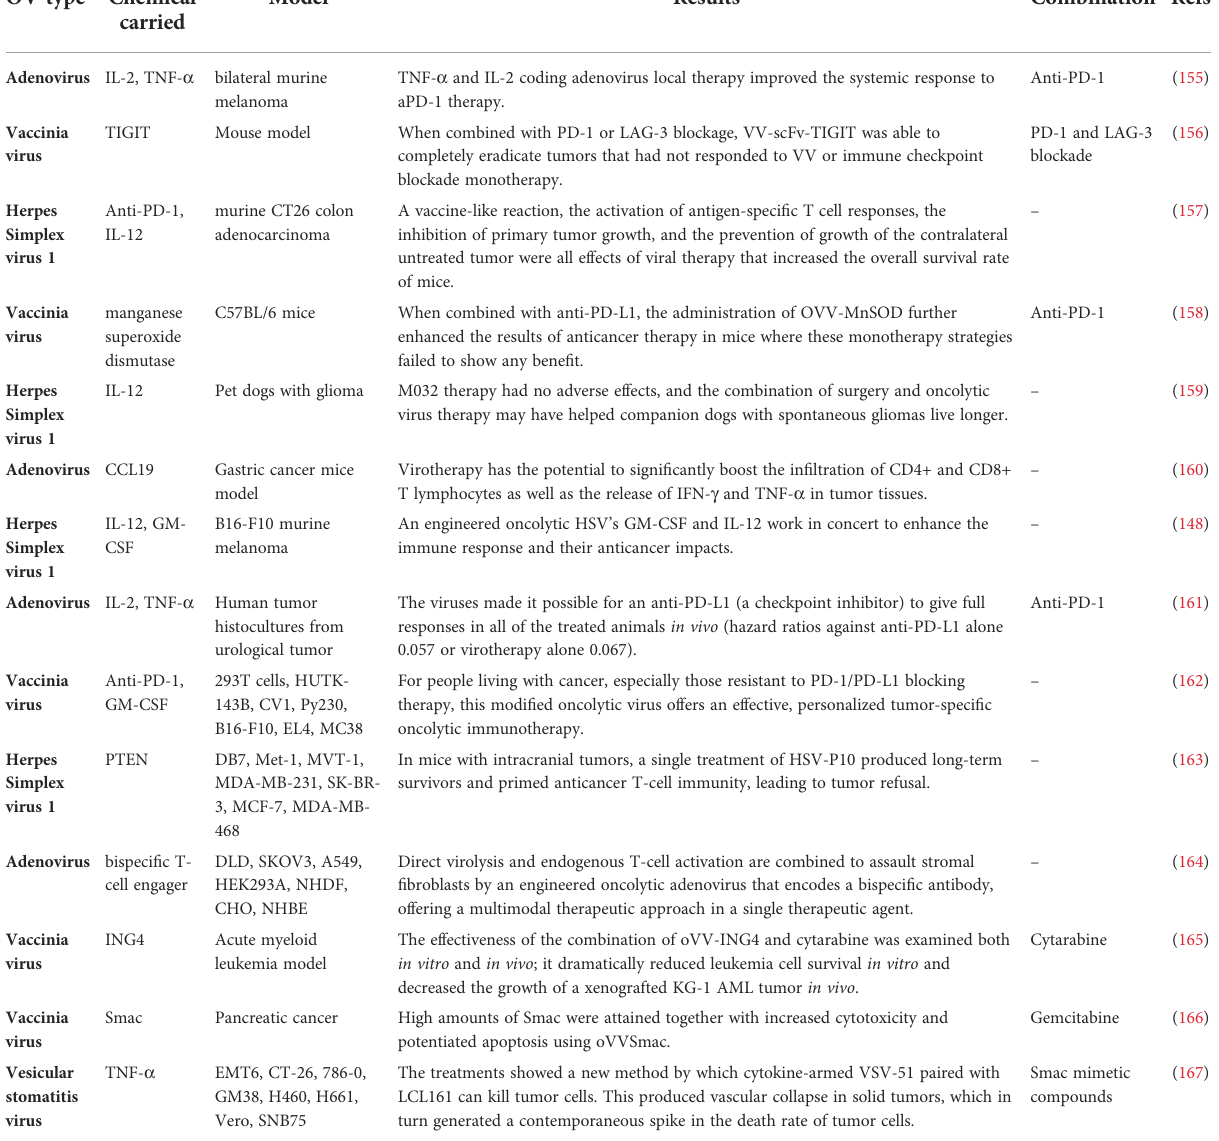
TABLE 1 Most recent recombinant OV used in the treatment of several cancer